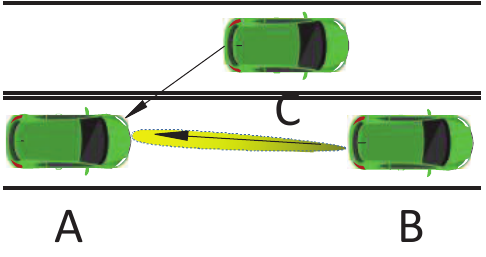
Figure 1. Coexistence scenario between automotive MIMO radar and V2V